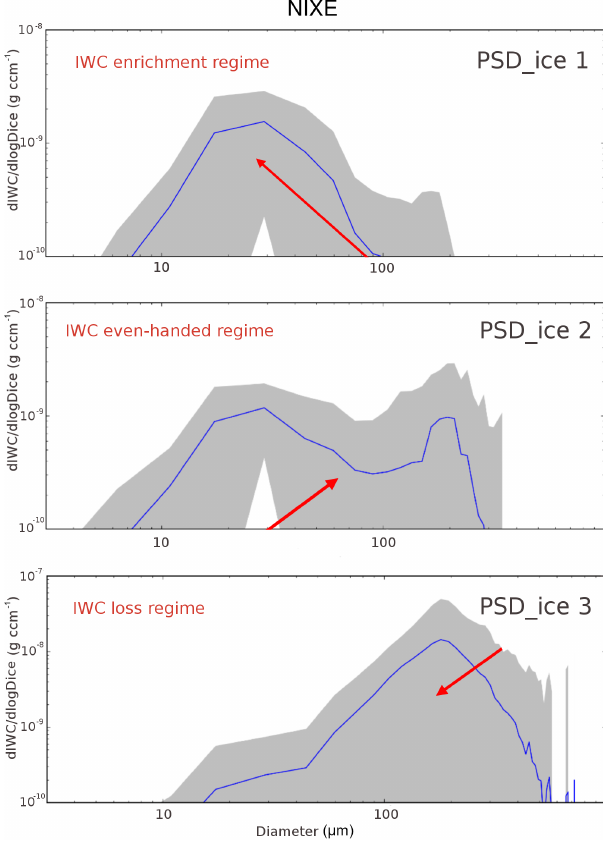
Figure 13. Three types of cirrus mass size distributions dIWC / dlog D ice exemplarily for the flight on 4 April 2014. Blue lines represent the mean PSDs and the gray area represents the stan- dard deviation. to clearly distinguish the actual particle size from the mean mass radius R ice of the ice particle population used in Fig.